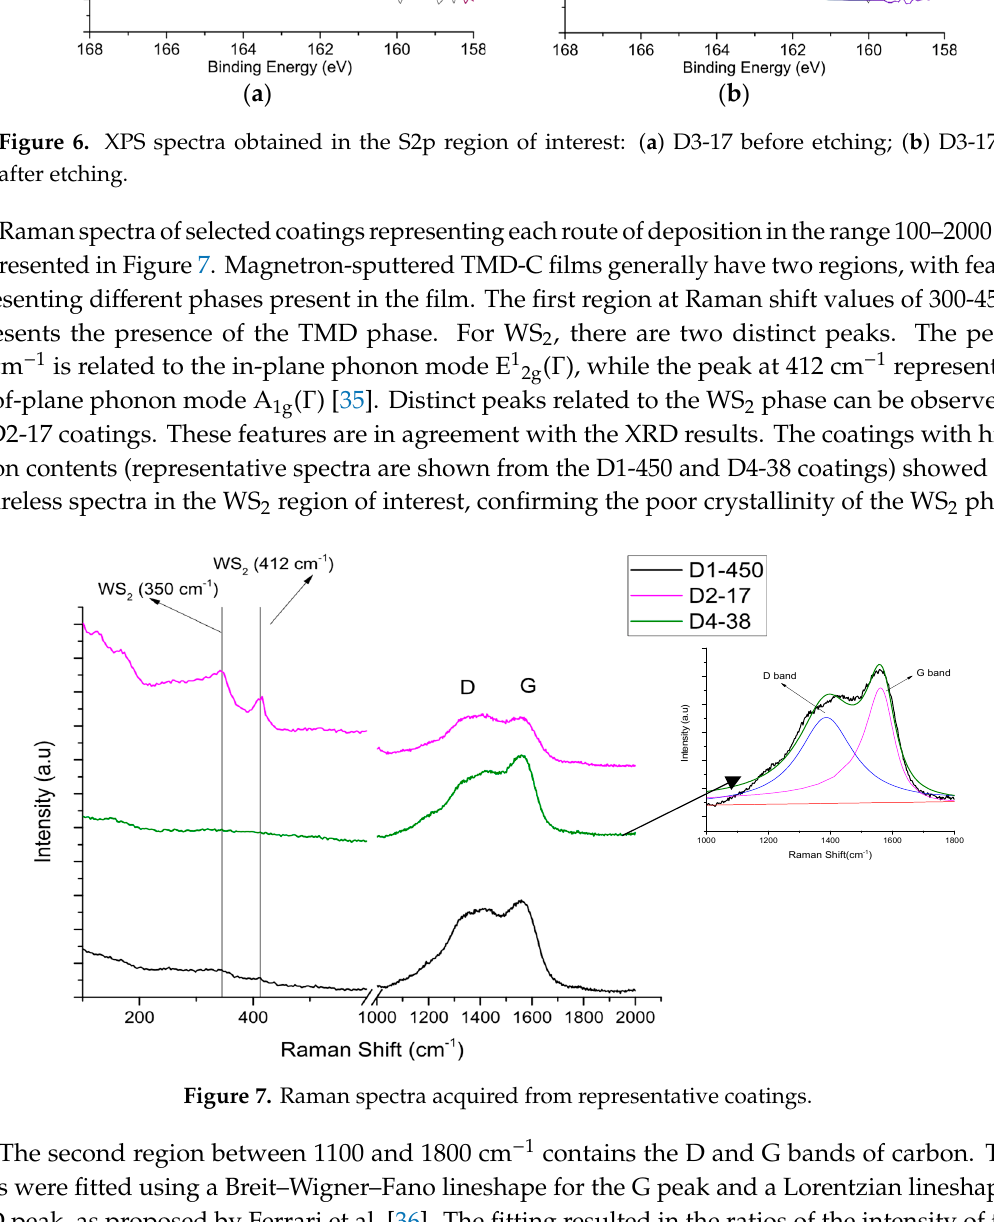
Figure 6. XPS spectra obtained in the S2p region of interest: ( a ) D3-17 before etching; ( b ) D3-17 after etching.